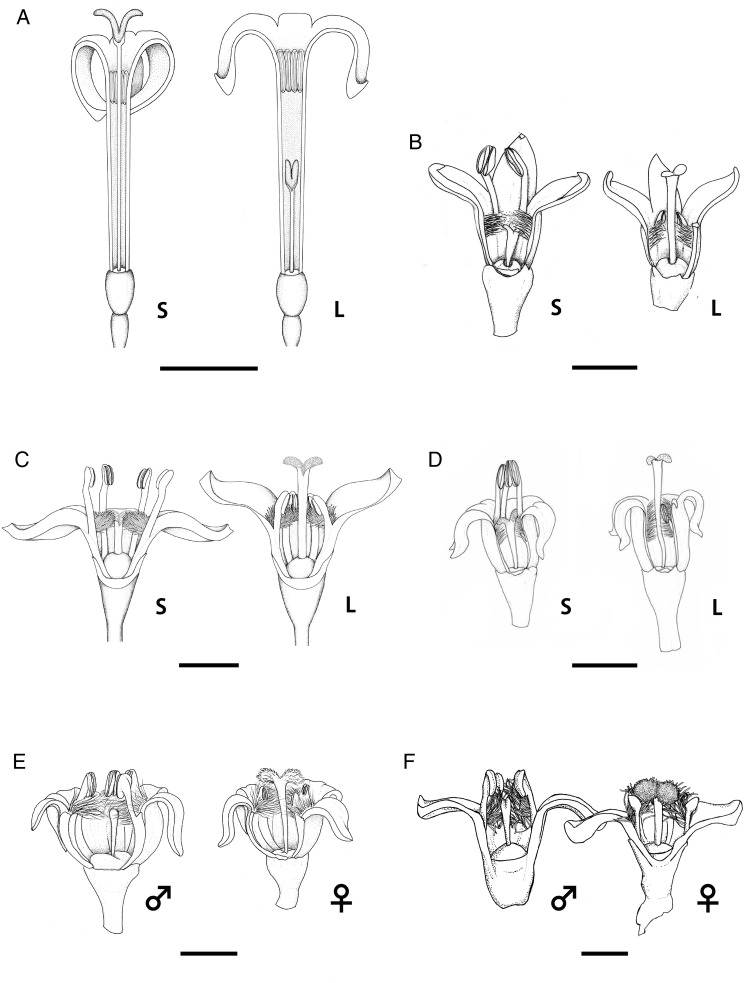
Flowers of six Psychotria species in Japan and Taiwan. Two flower morphs in distylous P. homalosperma (A), P. boninensis (B), P. cephalophora (C), P. serpens (D) and two flower morphs in dioecious P. rubra (E) and monoecious P. manillensis (F). S, short-styled flower; L, long-styled flower; ♂, male flower; ♀, female flower. Scale bars represent 5 mm in (A) and 2.5 mm in (B) to (F). Drawings are modified after Watanabe et al. (2014a) (A), Kondo et al. (2007) (B), Watanabe et al. (2015) (C), Sugawara et al. (2013) (D), Watanabe et al. (2014b) (E).